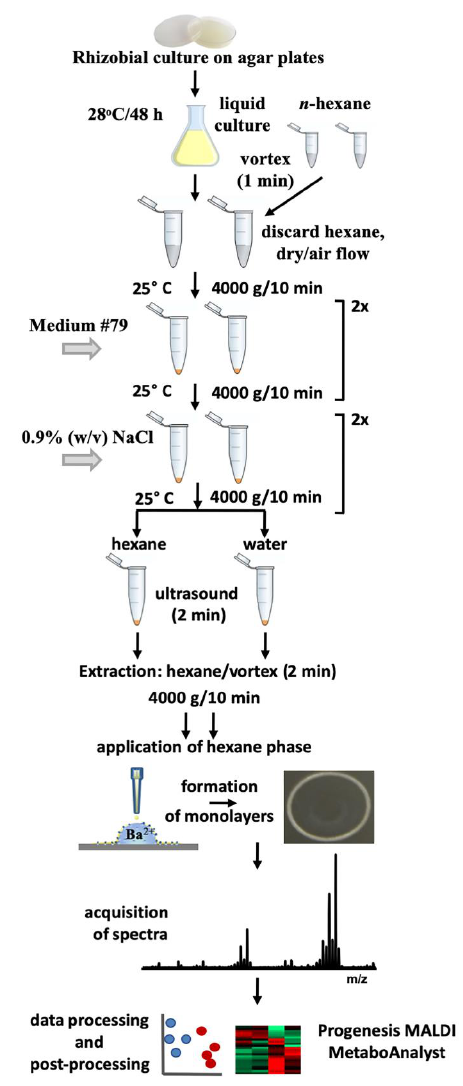
Figure 2. Experimental setup, applied for analysis of rhizobial free fatty acids by the combination of Langmuir technology and matrix-assisted laser desorption / ionization-time of flight mass spectrometry